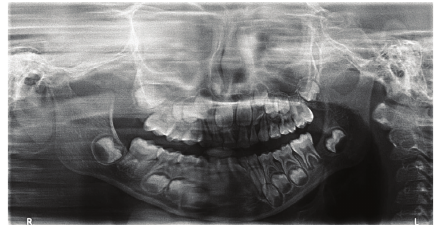
Figure 2: Orthopantomograph showing no bony involvement.